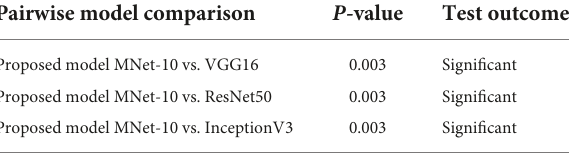
TABLE 7 Results of Wilcoxon signed-ranked test. Pairwise model comparison P -value Test outcome Proposed model MNet-10 vs. VGG16 0.003